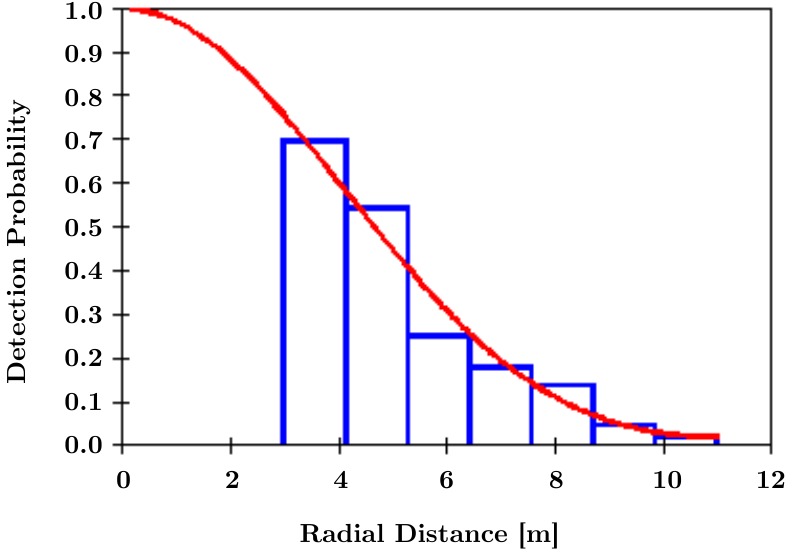
Figure 7. CTDS detection probability. We transformed our distance measurements into seven intervals (visualized in blue) from which the detection probability (visualized in red) was derived using